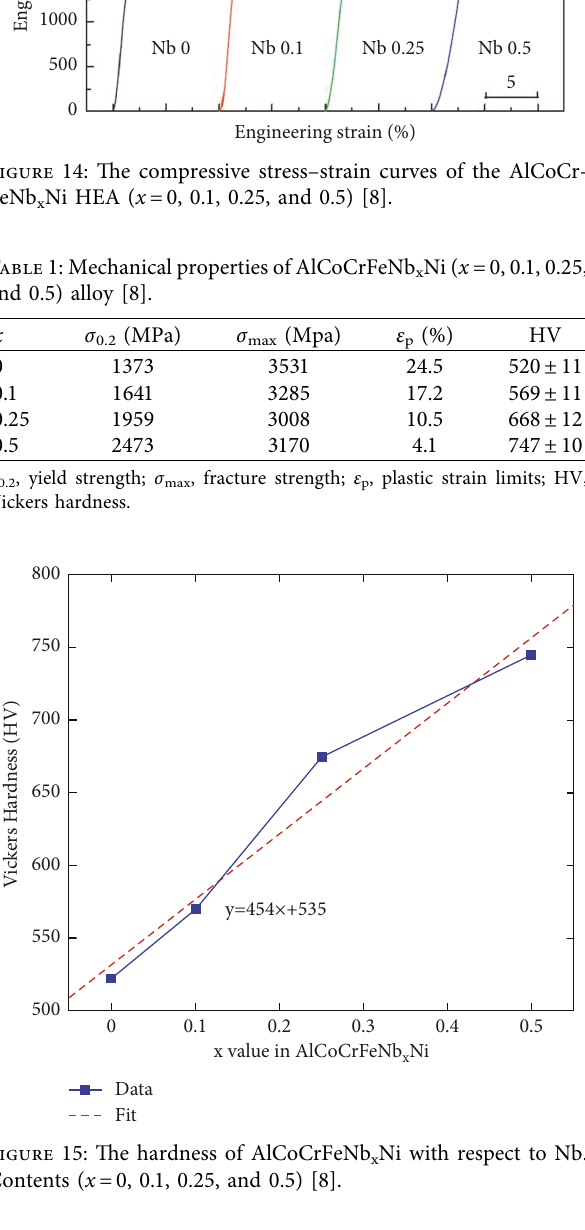
x Ni with respect to Nb.